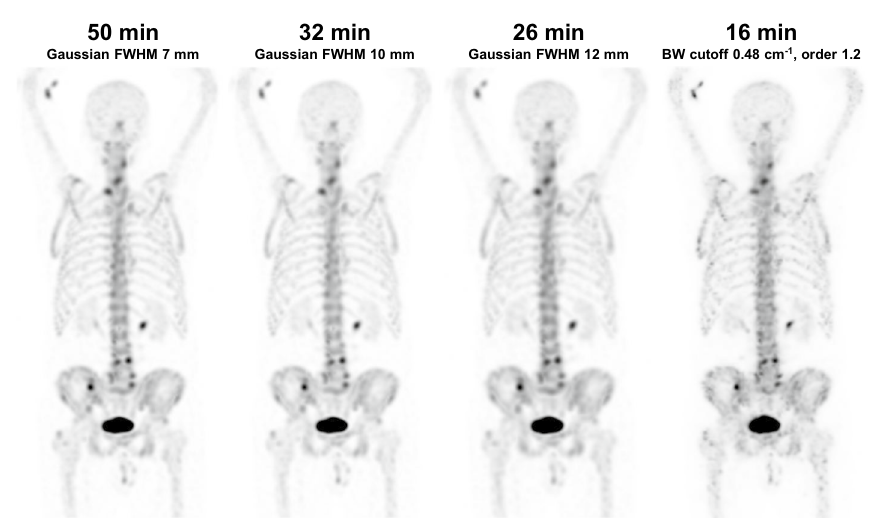
Fig. 2 Whole-body 99m Tc-HMDP SPECT maximum intensity projections of a 72-year-old prostate cancer patient with different acquisition times and post-processing filters. The 50-, 32-, and 26-min images are filtered using Gaussian filters with FWHMs of 7, 10, and 12 mm, respectively, and the 16-min image is filtered using a Butterworth filter with a cutoff frequency of 0.48 cycles/cm and an order of 1.2. The 16-min image is acquired and processed using the same parameters as in an earlier study